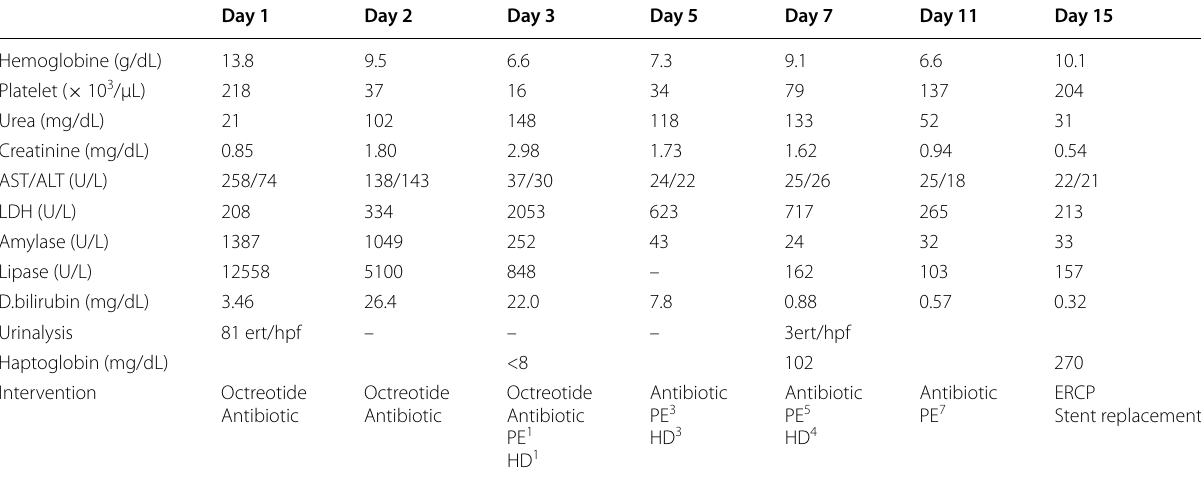
AST Aspartate aminotransferase, ALT Alanine aminotransferase, LDH Lactate dehydrogenase, D. Bilirubin Direct bilirubin, PE Plasma exchange, HD Hemodialysis, ERCP Endoscopic retrograde